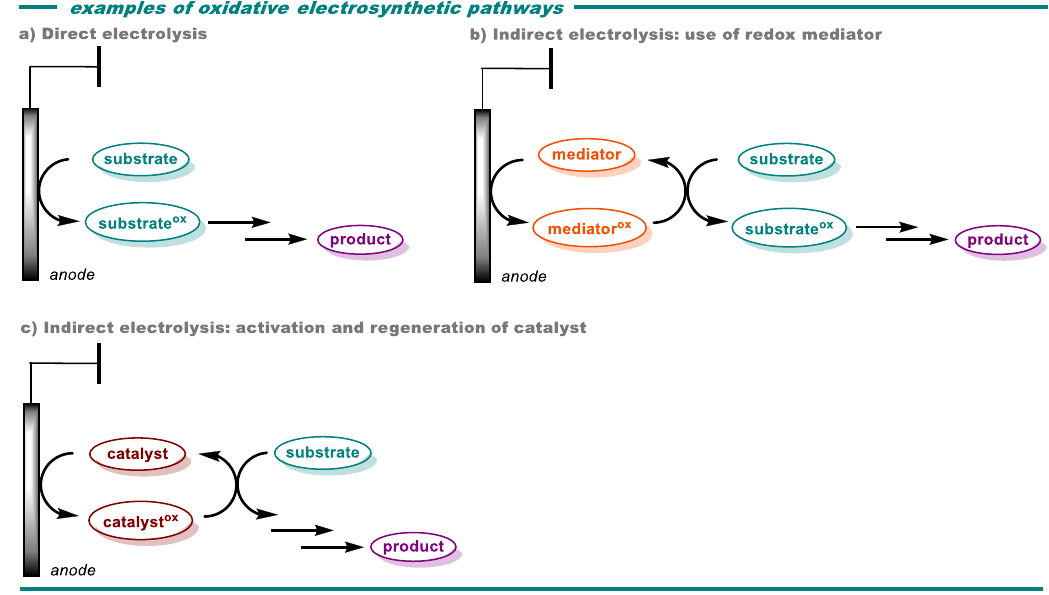
Figure 1. Examples of electrosynthetic pathways for substrate oxidation (cathodic reaction not shown) ( a ) direct anodic oxidation; ( b ) indirect anodic oxidation; ( c ) indirect oxidation by anodic activation and regeneration of catalyst.